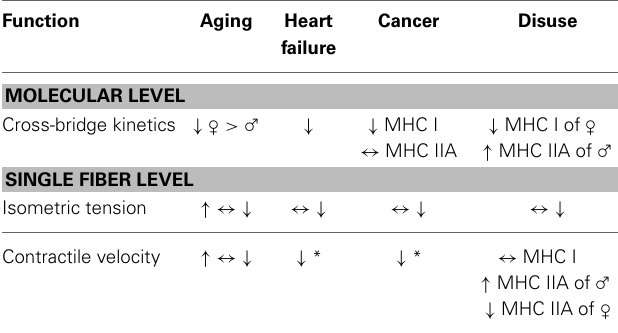
Table 2 | Summary of functional changes in single fiber and myofilament structure with aging, disease, and